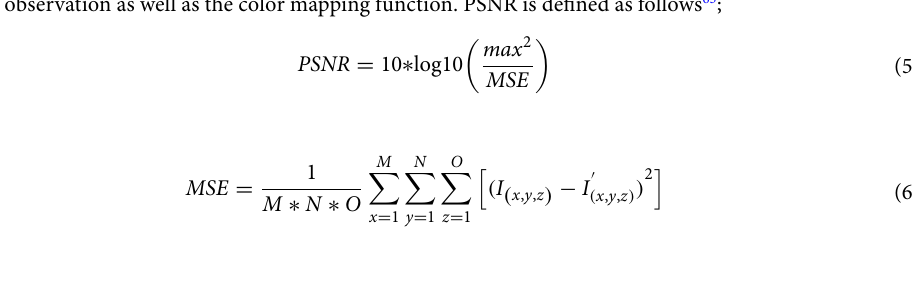
Loss L PSNR and L 2 norms are used to define the network learning strategy to reconstruct a clean image from its noisy observation as well as the color mapping function. PSNR is defined as follows 63 ;